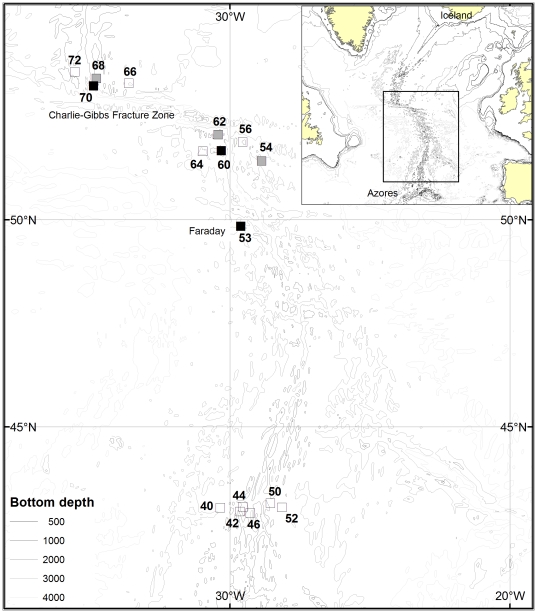
Study area and locations sampled with the bottom trawl.RV G.O.Sars, July 2004.